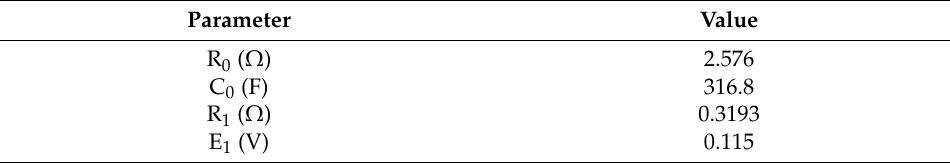
Figure 3. A dynamic model for EMG-BES stack. Table 1. EMG-BES cell model parameters.